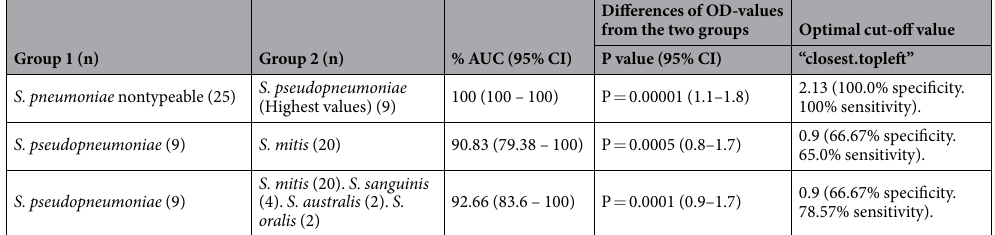
Table 3 and Fig. 1 present the optimal cut-off value and the Area Under the Curve (AUC) for differentiating all the tested strains, based on their bile solubility OD-values. Choosing a cut-off OD-value of 2.1 showed an excel- lent AUC of 100% (95% CI 100–100), which showed no false negative OD-values for nontypeable S. pneumoniae , while one S. mitis strain (OD-value of 2.7) showed OD-values above a cut-off value of 2.1 (Fig. 1). The median bile OD-value for nontypeable S. pneumoniae (median OD value = 2.9) differed significantly from the median bile OD-value for S. pseudopneumoniae (OD value = 1.8) (P = 0.0005, 95% CI 0.8–1.7). Choosing a cut-off OD-value of 0.9 for differentiating S. pseudopneumoniae from S. mitis , showed a good AUC of 90.83% (95% CI 79.38–100). The median OD-value for S. pseudopneumoniae (median OD value = 1.8) differed significantly from the median bile OD-value for S. mitis (OD value = 0.1) (P = 0.0005, 95% CI 0.8–1.7). Choosing a cut-off OD-value of 0.9 for differentiating S. pseudopneumoniae from the other streptococcal species tested ( S. oralis , S . sanguinis , S. australis) showed a good AUC of 92.66% (95% CI 83.6–100). The median bile OD-value for S. pseudopneumoniae (OD value = 1.8) differed significantly from the median bile OD-value for other strains ( S. oralis , S . sanguinis , S. australis) (OD value = 0.1) (P = 0.0001, 95% CI 0.9–1.7). Comparing the median bile OD-value for S. mitis (OD value = 0.1) with the combined median bile OD-value for other strains ( S. oralis , S . sanguinis , S. australis) (OD value = 0.1) showed no significant difference, P = 0.4 and a CI of (95%, CI − 0.1–0.2). The AUC was not calculated.